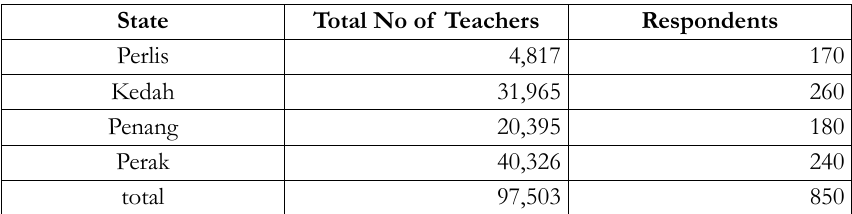
Table 2. Summary of Respondents for the Current